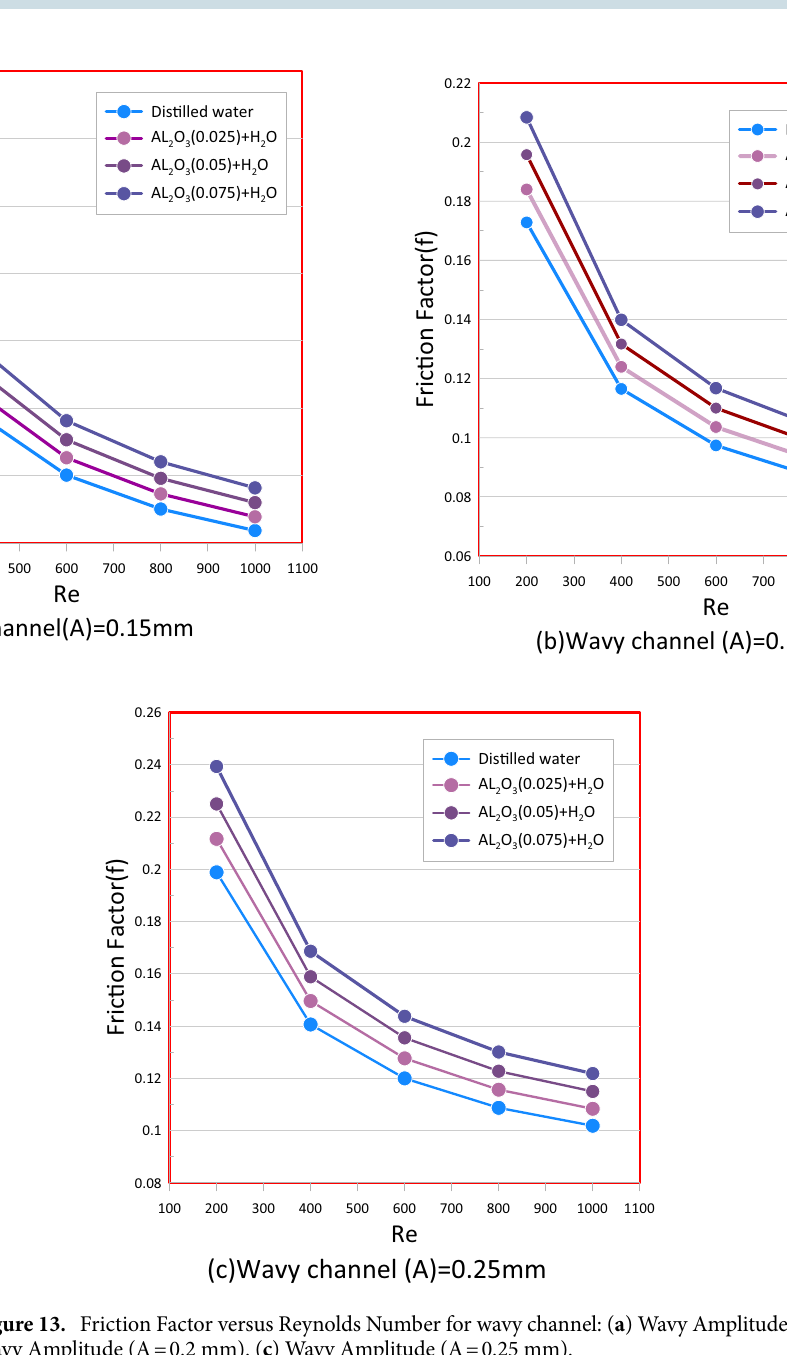
Figure 13. Friction Factor versus Reynolds Number for wavy channel: ( a ) Wavy Amplitude (A = 0.15 mm). ( b ) Wavy Amplitude (A = 0.2 mm). ( c ) Wavy Amplitude (A = 0.25